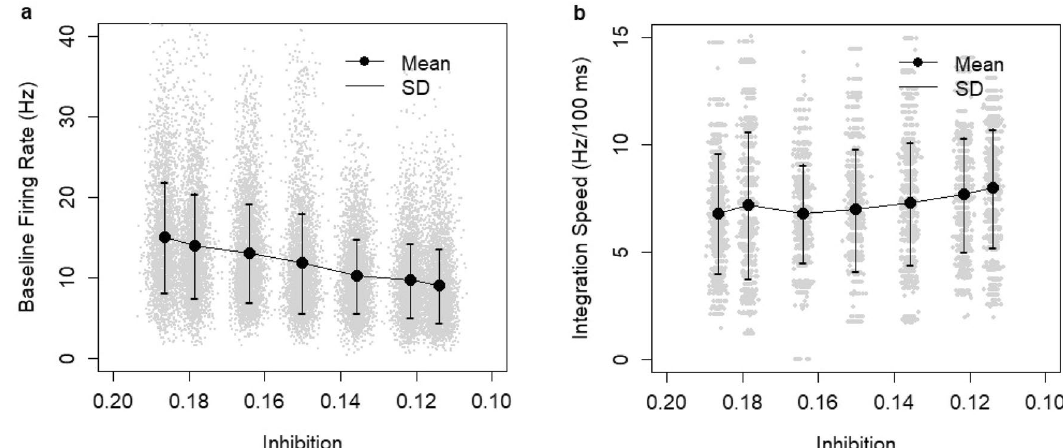
Figure 6. Effects of the manipulation of the inhibition constant. ( a ) Baseline firing rate (Hz): average in the decision set during the spontaneous run. ( b ) Integration speed (Hz/100 ms): average based on N = 7000 model runs with random contrast levels: 4.98–13.53% (i.e., N = 1000 per inhibition